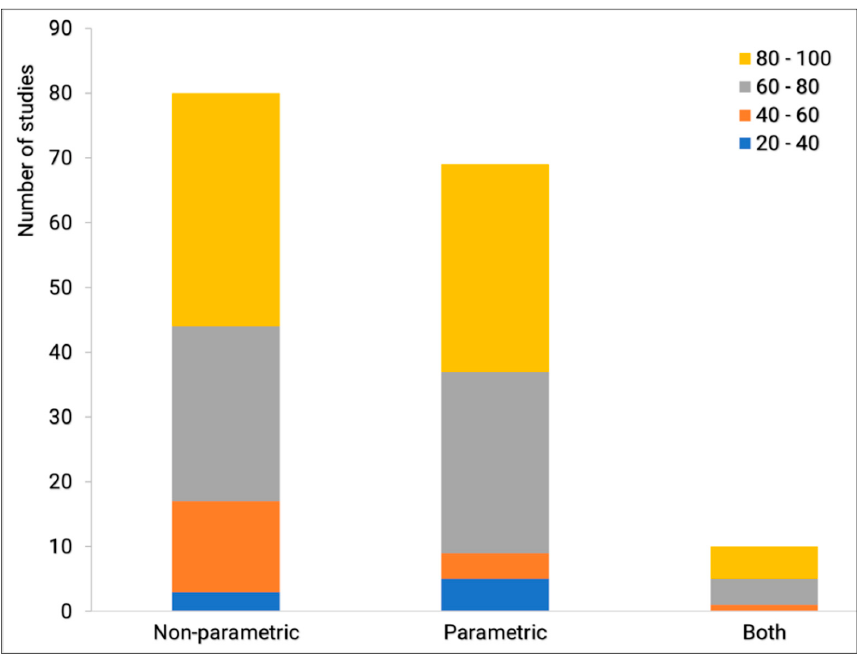
Figure 14. Overall accuracy per methods category.